Question: Looking at the figure, what chart type is it?
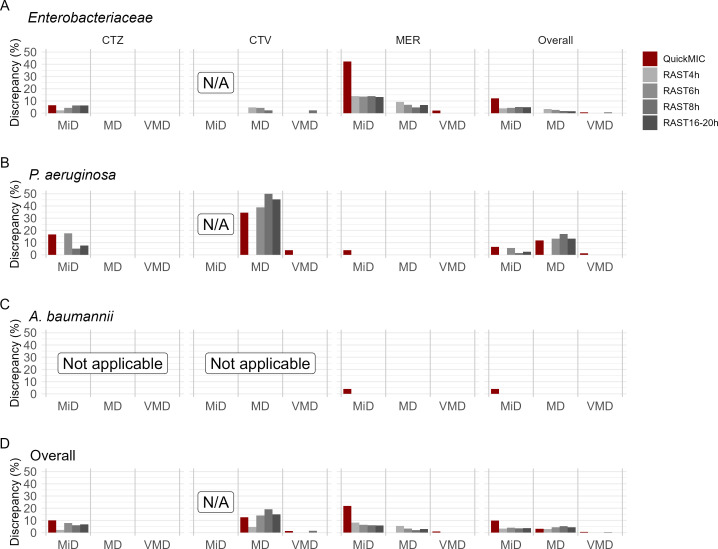
Answer: bar